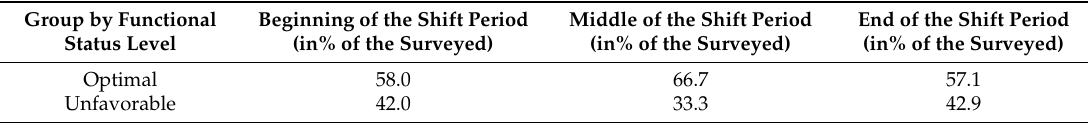
Table 1. Distribution of the workers by the level of functional status during the shift period.